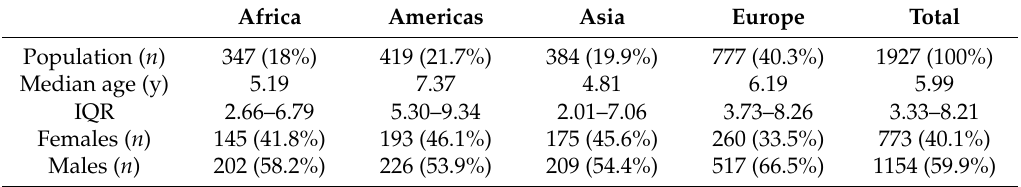
Table 1. Characteristics of the study population by continent of origin, gender, and median age. Africa